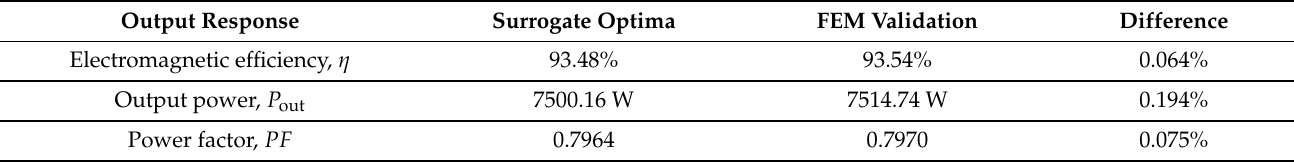
Table 11. Validation of surrogate optimal solution of the proposed optimization routine (part 1—surrogate optimization) with FEM simulationdesign–multivariate optimization problem.